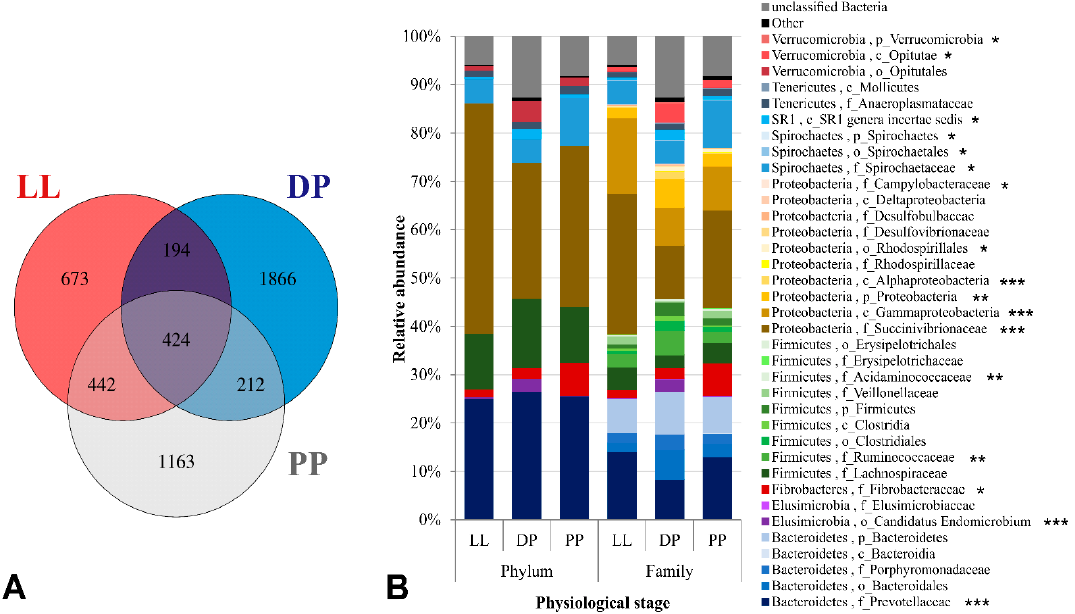
Figure 2. Distribution of bacterial-OTUs and active rumen bacterial taxa in different groups. ( A ) Venn diagram of OTUs specific to the V3–V4 region of bacterial 16S rRNA. The bacterial OTUs identified during different physiological stages were grouped as either unique or shared OTUs between LL, DP, and PP microbiome. ( B ) Relative abundance (percent reads out of total reads) of nine bacterial phyla and 36 bacterial families are shown. Phyla with relative abundance <1% were grouped as “Other”. Usually, family (f) was indicated; when family was not identified, lower identified taxa were indicated. The significantly different bacterial taxa between physiological stages are indicated by p values (ANOVA). * p ≤ 0.05, ** p ≤ 0.01, *** p ≤ 0.001. Microorganisms 2021 , 9 , x FOR PEER REVIEW